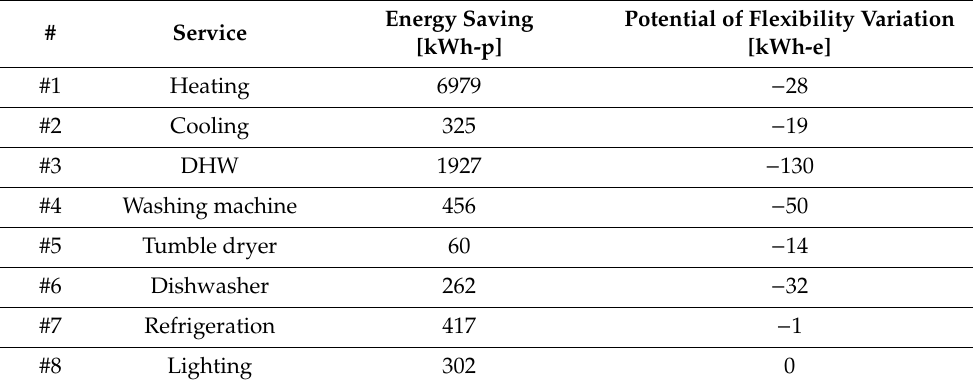
Table 5. Energy saving and changes in potential of flexibility: average